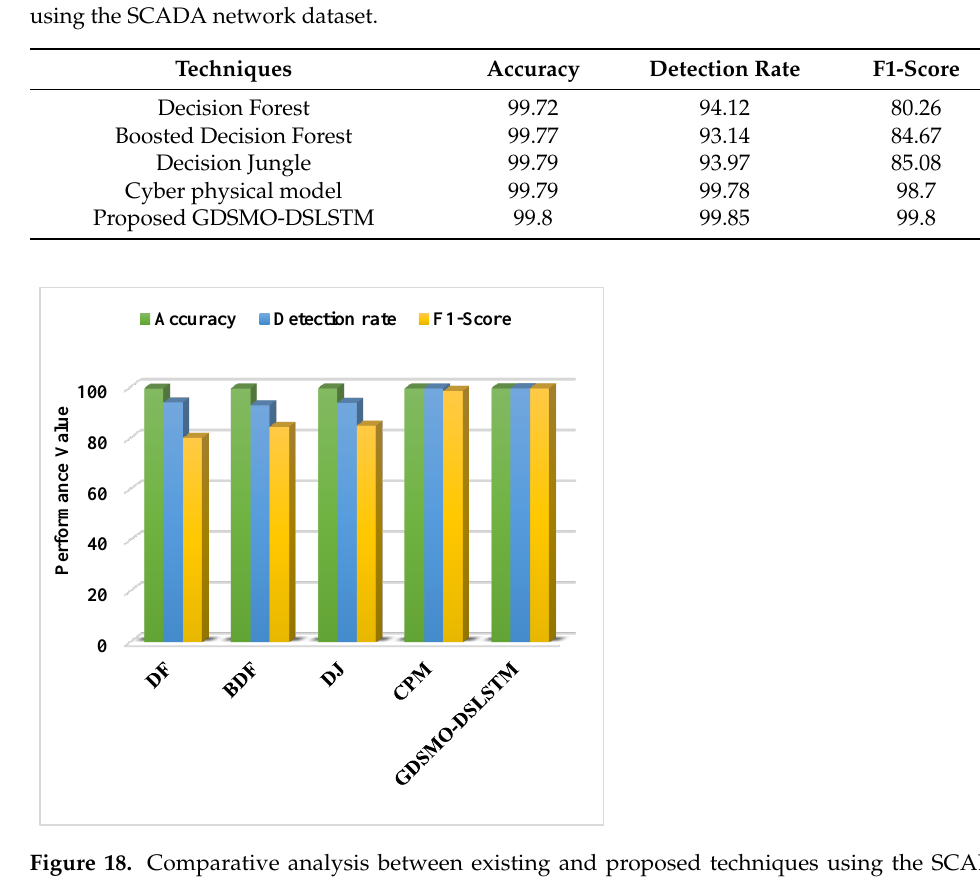
Table 6. Comparative analysis between the existing and proposed deep learning techniques based on